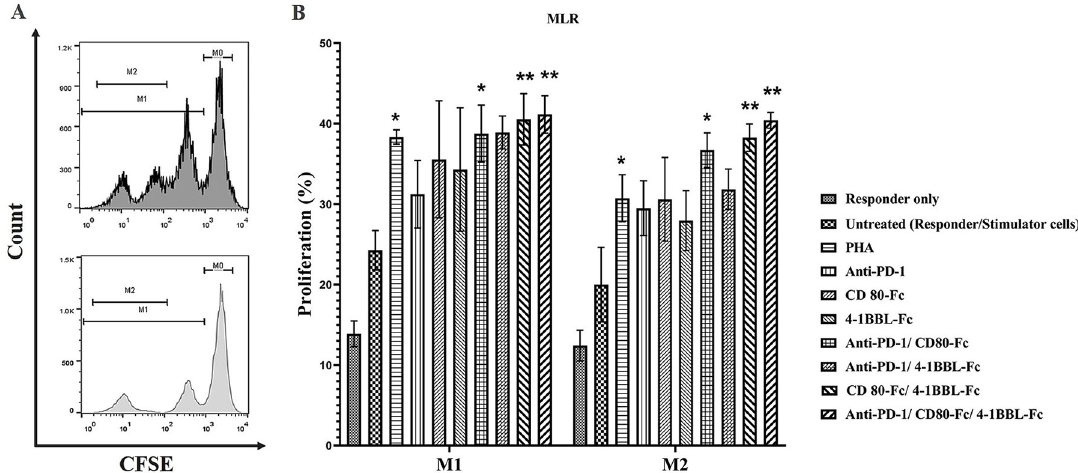
Fig 3. T cell proliferation induction of anti-PD-1, CD80-Fc, and 4-1BBL-Fc proteins in mono and combination treatments. For an allogeneic MLR, responder cells from 6 healthy donors were stained with CFSE and mixed with γ -irradiated PBMCs at a 1:1 ratio. PBMCs were harvested after 5 days and analyzed by flow cytometry. (A) Histogram plots depict examples of two populations used in this study for MLR analysis: M1 (divided) and M2 (highly divided) populations of untreated (Light gray) and PHA conditions (dark gray). M2 is a subset of the M1 population that contains cells with a high division rate. (B) Percentage of CFSE intensity was measured in different conditions and statistical analysis was performed using a one-way ANOVA test ( � p � 0.05, �� p � 0.01). The column height represents the average percentage of the CFSE- labeled cells and error bars are ± SEM.